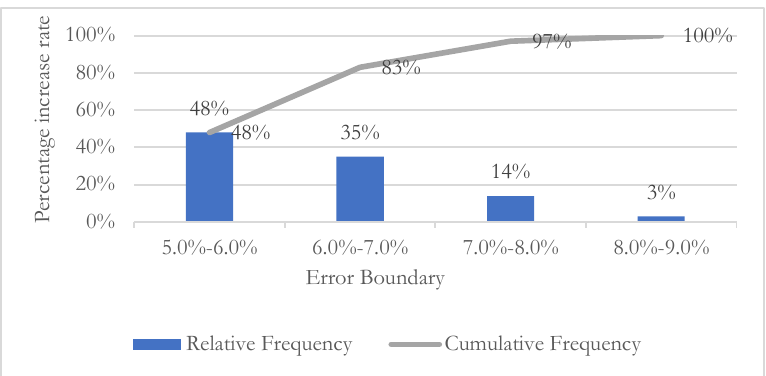
Fig. 4. Reviewed upper bounds of solution errors for the relaxation of the second constraint (u=2).